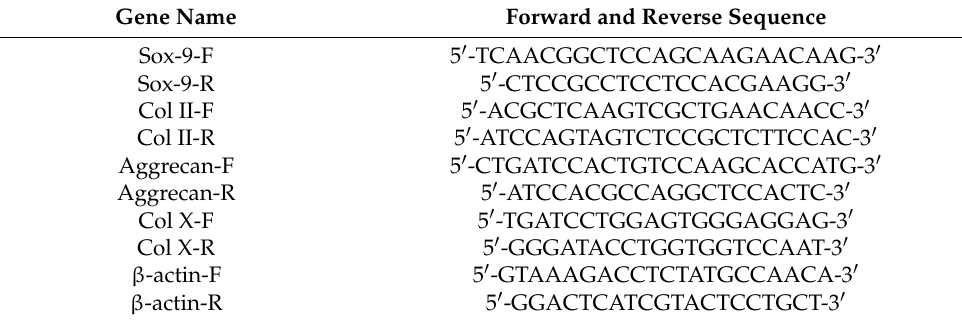
Table 1. Primer sequences used in qRT-PCR